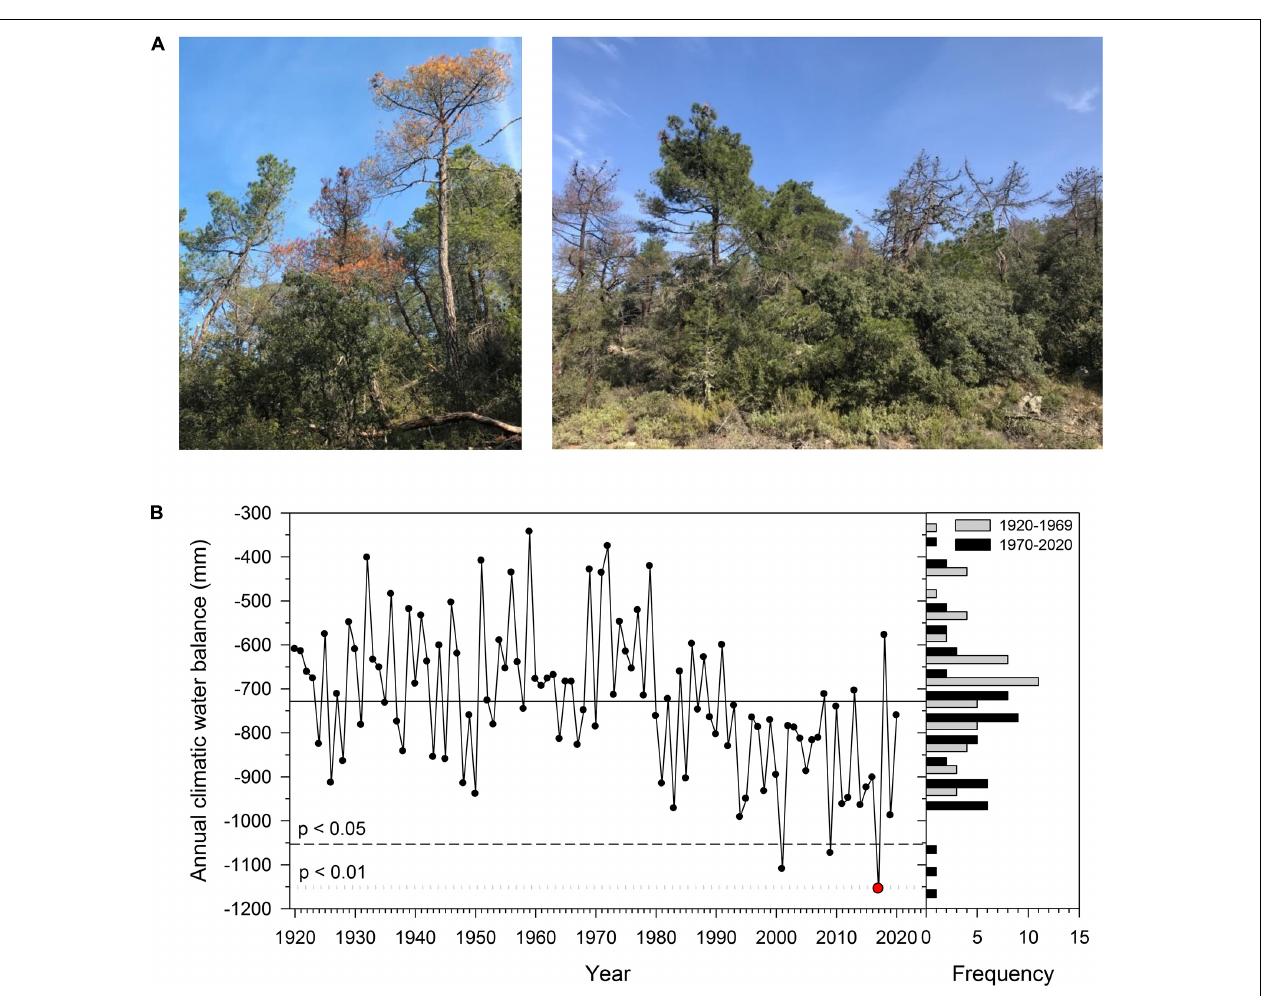
FIGURE 1 | (A) Views of non-declining (ND), declining (D), dying, and recently dead Pinus pinaster trees sampled in the Miedes study site. (B) Temporal variability of the annual climatic water balance (P-PET) according to the data from the Daroca meteorological station. The dashed and dotted lines show the threshold